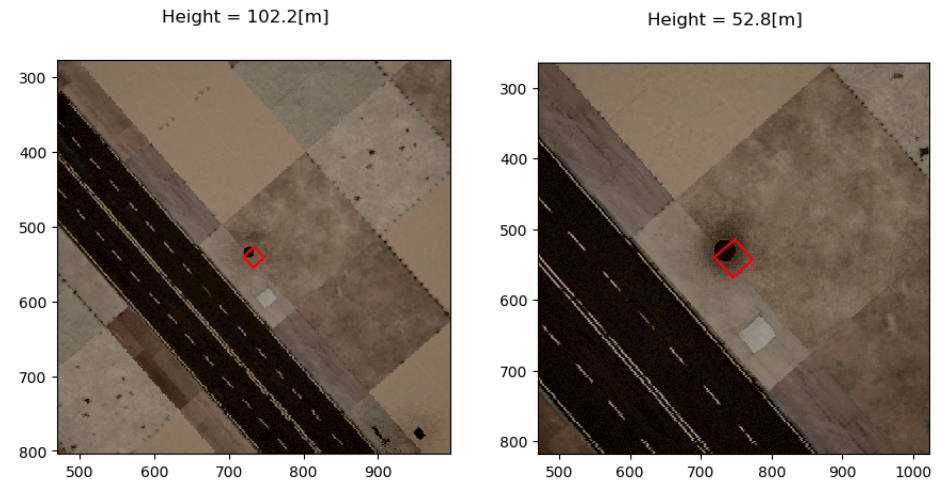
Figure 12. Semantic segmentation input: telephone booth partially occupies the